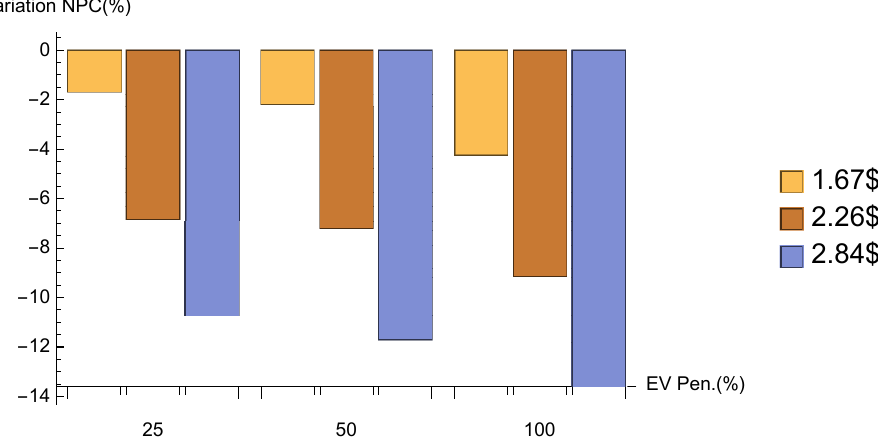
Figure 9. NPC variations for different EV penetration levels and diesel prices between cases A and